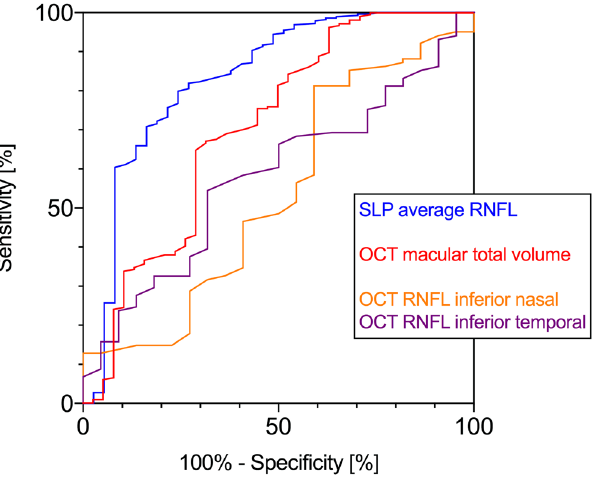
Figure 4. Receiver operating characteristic curves of SLP average RNFL thickness, OCT RNFL inferior nasal and OCT RNFL inferior temporal thickness and OCT total macular volume are